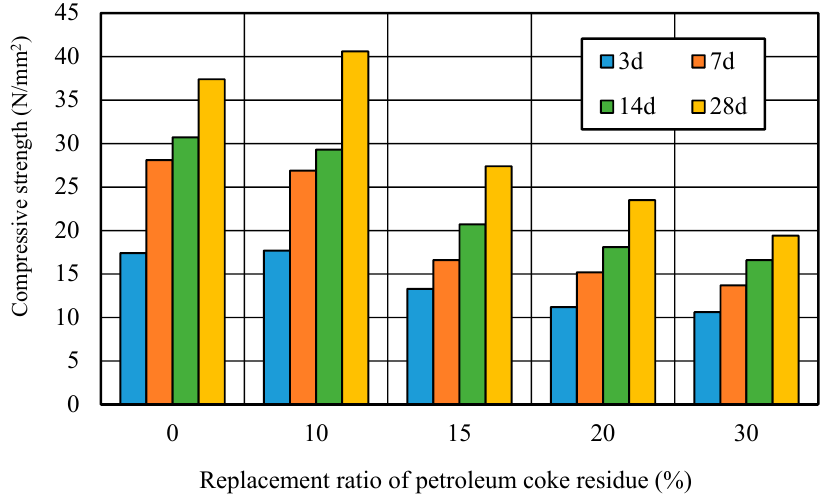
Figure 10. Strength of petroleum coke residue concrete with different replacement ratios.